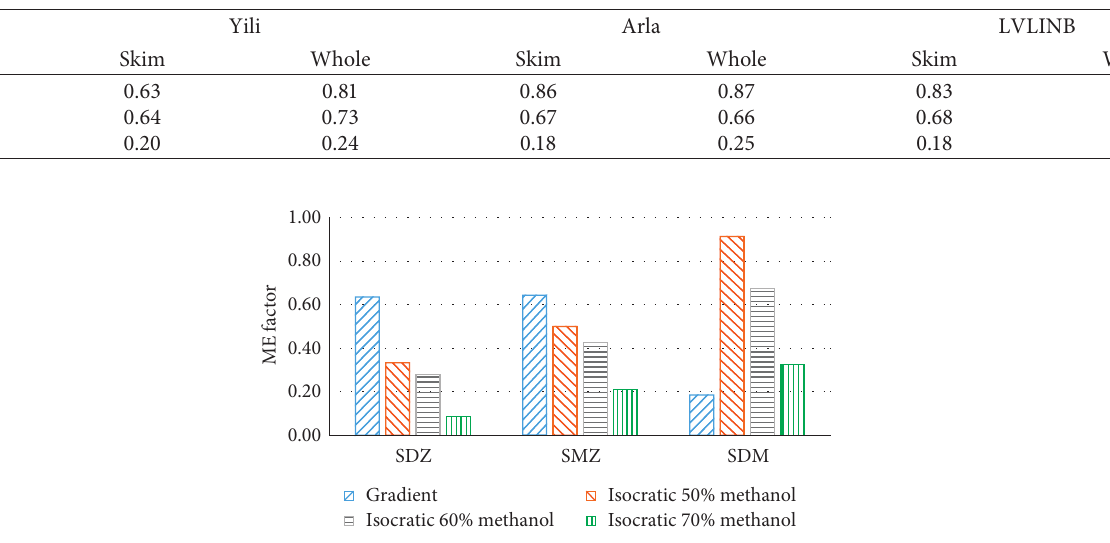
Table 1: The matrix effect factors of the target analytes in six milk samples ( n � 3).